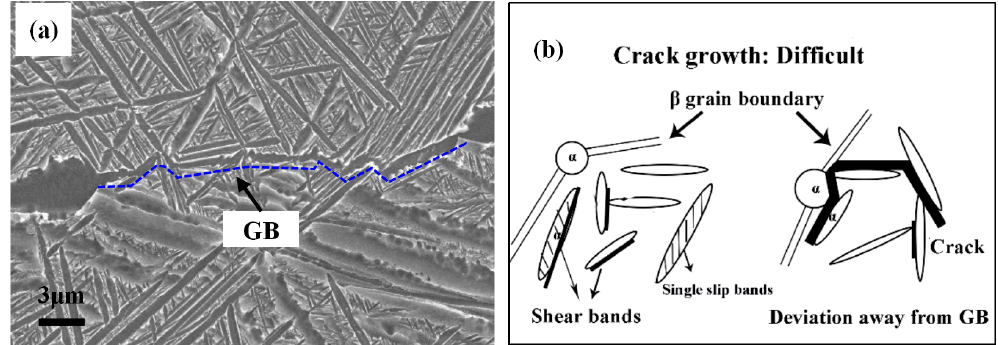
Figure 7. The features of the grain boundary α phase and the schematic diagram of crack growth behavior: ( a ) the discontinuous and “zig-zag” GB α phase, ( b ) the crack mainly initiates at α l , and it will change the direction of propagation when it encounters the equiaxed α phase at the β grain boundary, which leads to an intergranular